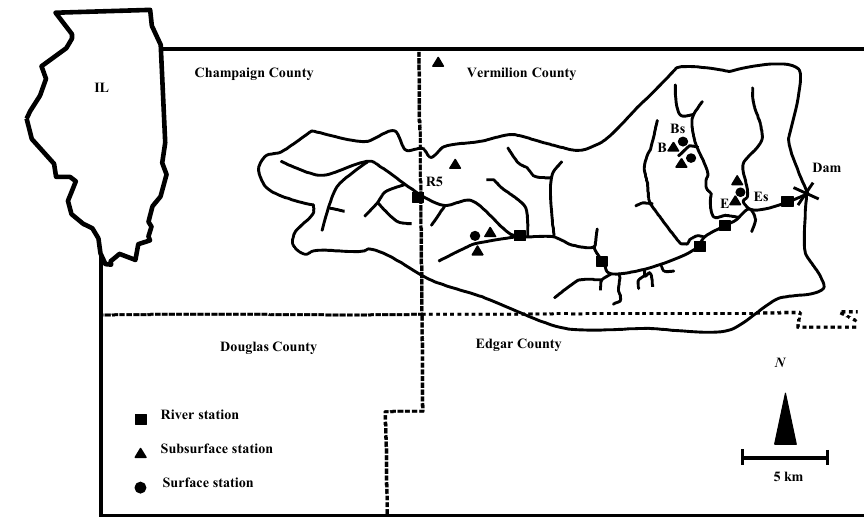
Figure 1. Cali and Vali represent calibration and validation, respectively. Table 3. Calibrated values of adjusted parameters for tile flow and nitrate-N calibration of SWAT at sites B, E, Bs, Es, and